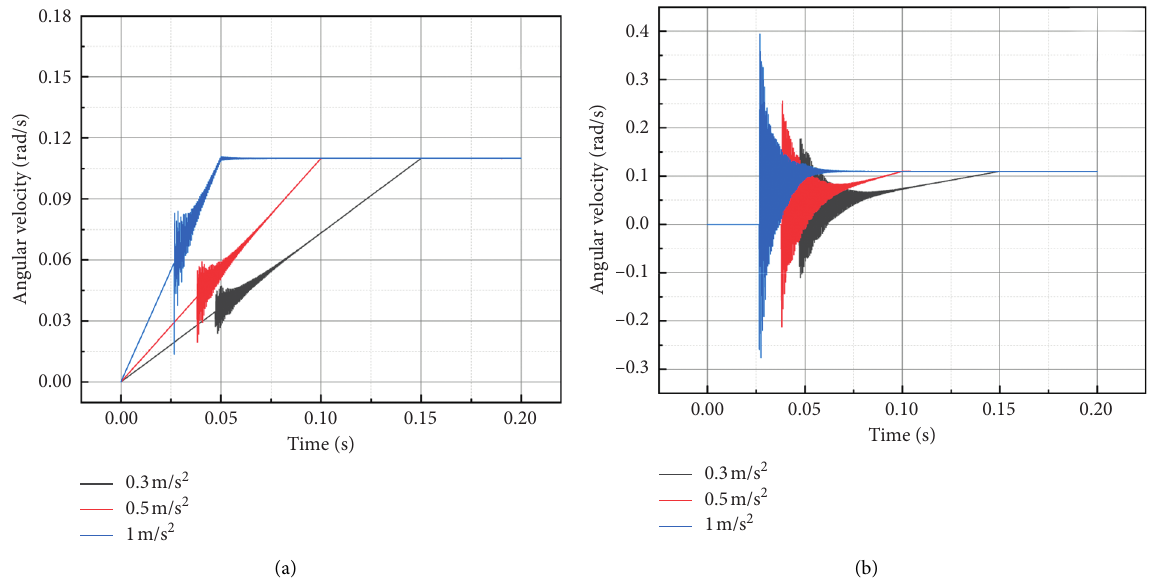
Figure 8: The comparison of angular velocity of axle and wheel spline under three loading cases. (a) The comparison of angular velocity of axle spline under three loading cases. (b) The comparison of angular velocity of wheel spline under three loading cases.